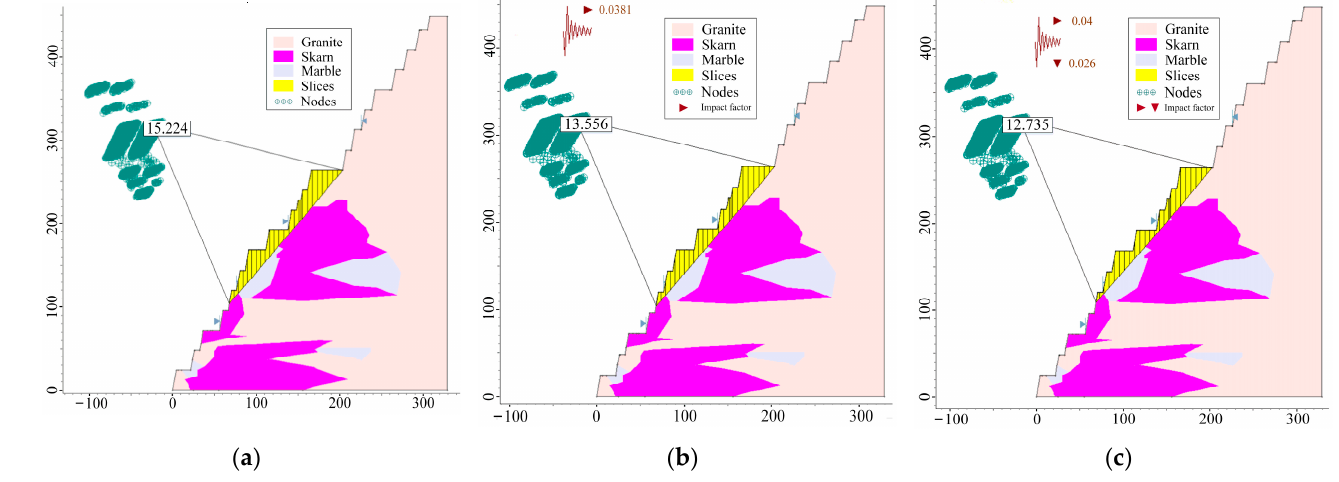
Figure 11. Results of the adjusted R3 slope for the strength reduction method.